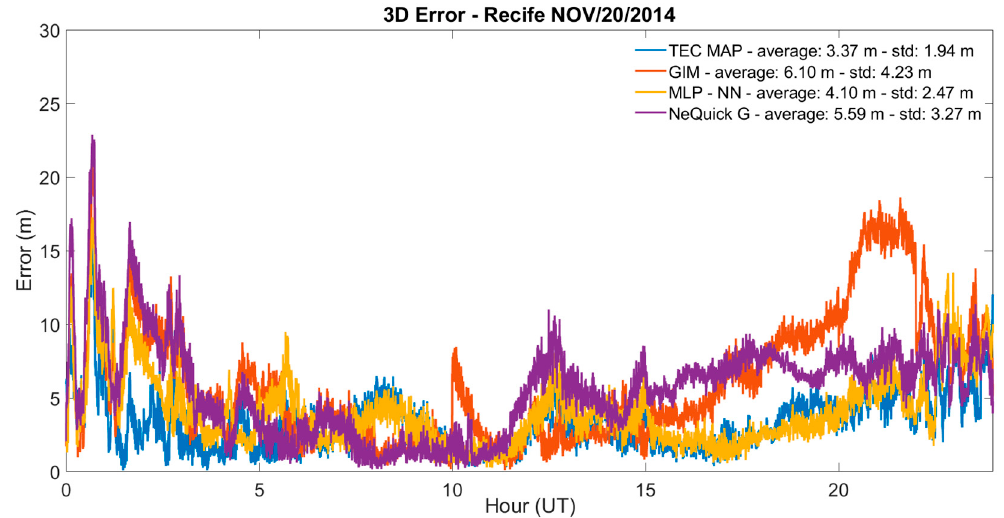
Figure 9. Example of 3D single point positioning error for 20 November 2014, over the RBMC station in Recife. The error of the proposed model (yellow line) is typically smaller than the NeQuick G (purple line) and GIM (orange line).